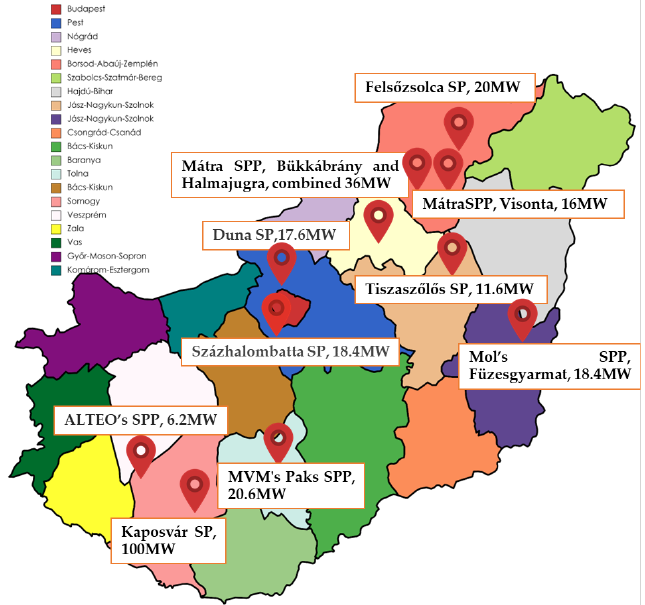
Figure 2. The largest solar power plants in Hungary